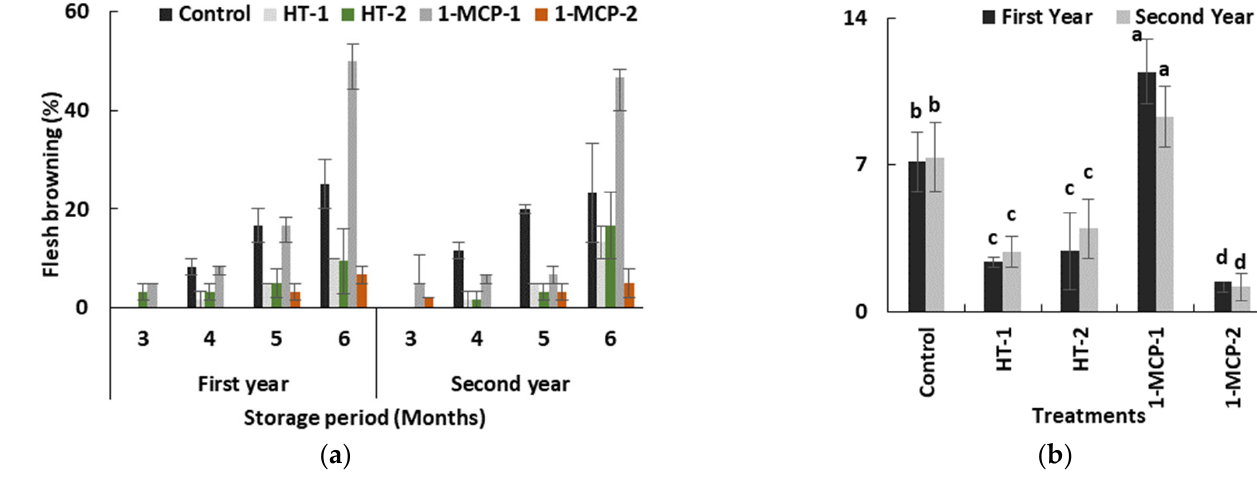
Figure 3. The effect of the storage period of 6 months at 0 ± 1 ◦ C temperature, 85–90% relative humidity and regular air conditions ( a ) and different postharvest treatments ( b ) on flesh browning in- cidence of quince fruit during long-term cold storage period. Control—without postharvest treatment; HT-1—Hot water treatment at 50 ± 1 ◦ C for 3 min; HT-2—Hot water treatment at 50 ± 1 ◦ C for 5 min; 1-MCP-1—300 ppb 1-methylcyclopropane (1-MCP) treatment at 12 ◦ C for 20 h; 1-MCP-2—1000 ppb 1-MCP treatment at 12 ◦ C for 20 h. Vertical lines are the standard error of means. Different letters are significantly different, according to Tukey test, at p ≤ 0.05 significance